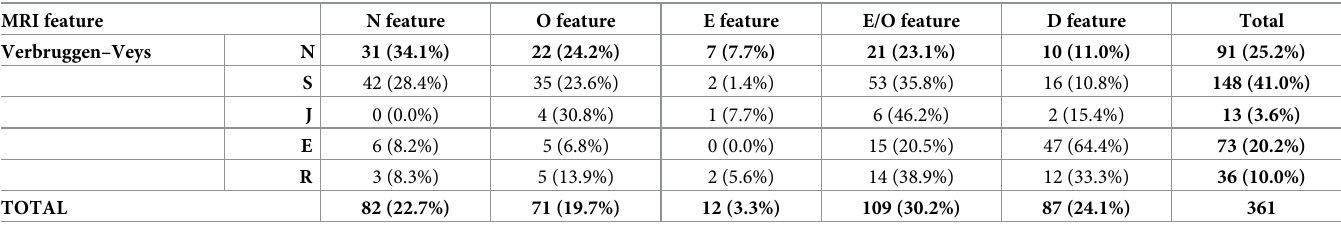
Table 4. The agreement between MRI features and RX for the interphalangeal joints of 2nd–5th finger.